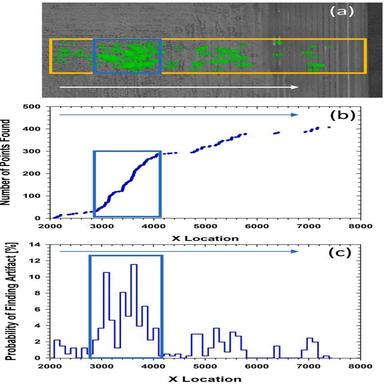
Machine vision identification of phase-separated regions in the sample containing 2% nonylphenol (a) with corresponding cumulative distribution (b) and probability histogram (c). The blue rectangle corresponds to the area with the highest concentration of points, and the arrow indicates the x direction.